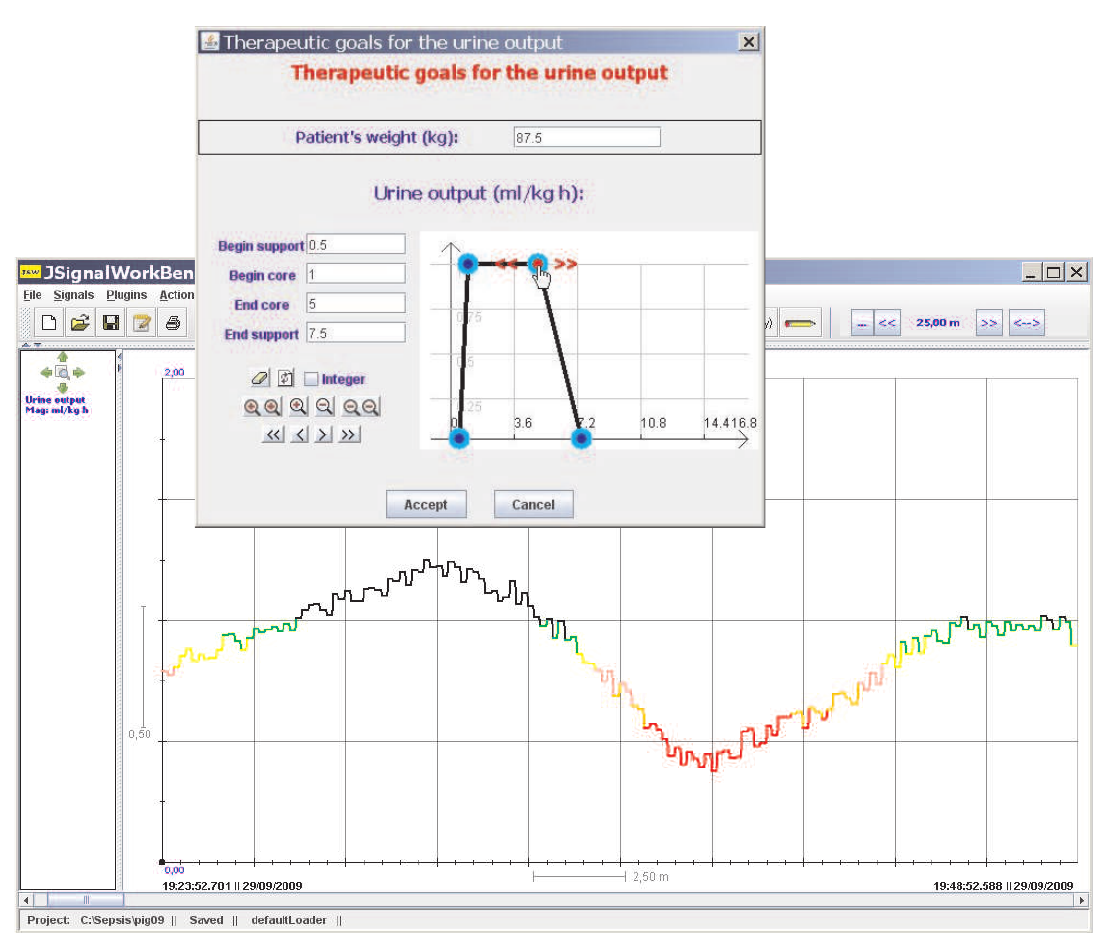
Figure 5. Main screen of the Java application showing urine output and the window that allows healthcare staff to set therapeutic